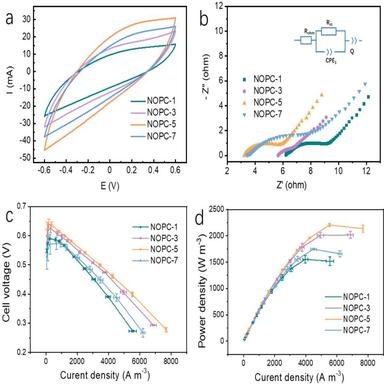
(a) Cyclic voltammograms (b) Nyquist plots of different electrodes in the anodic solution, (c) polarization curve, and (d) power output of different MFCs. In c and d, each value is the mean of two replicates.